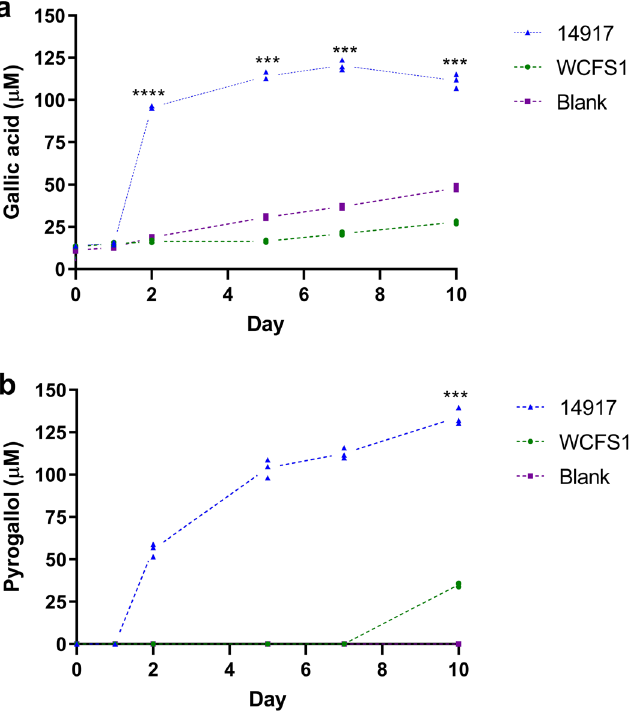
Figure 2. Time course phenolic metabolite-release by a TanA + and a TanA lacking L. plantarum strain cultured in a tannic acid-rich medium. ( a ) Gallic acid; ( b ) pyrogallol. Blue triangle, TanA+ ATCC 14917 strain; green circle, TanA lacking strain, WCFS1; purple square, blank (uninoculated media). Values of three independent experiments are shown. A two-way repeated-measures ANOVA with the Geisser–Greenhouse correction followed by Dunnett post hoc test was used to compare groups each time, using WCFS1 strain as a control. *** p ≤ 0.001, **** p ≤ 0.0001. A residual gallic acid from the tannic acid reagent can be observed at time zero. Due to tannic acid degradation at incubation conditions (30° C), gallic acid increases over